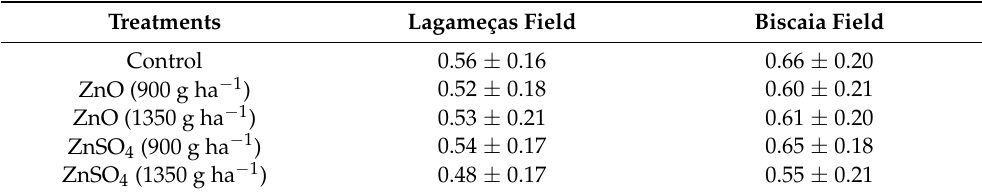
Table 1. Average ± S.D. of normalized difference vegetation index (NDVI) of the vineyards of Castel ã o and Syrah with ZnO and ZnSO 4 at different concentrations. Information collected after the 4th foliar application on 22 August 2019.